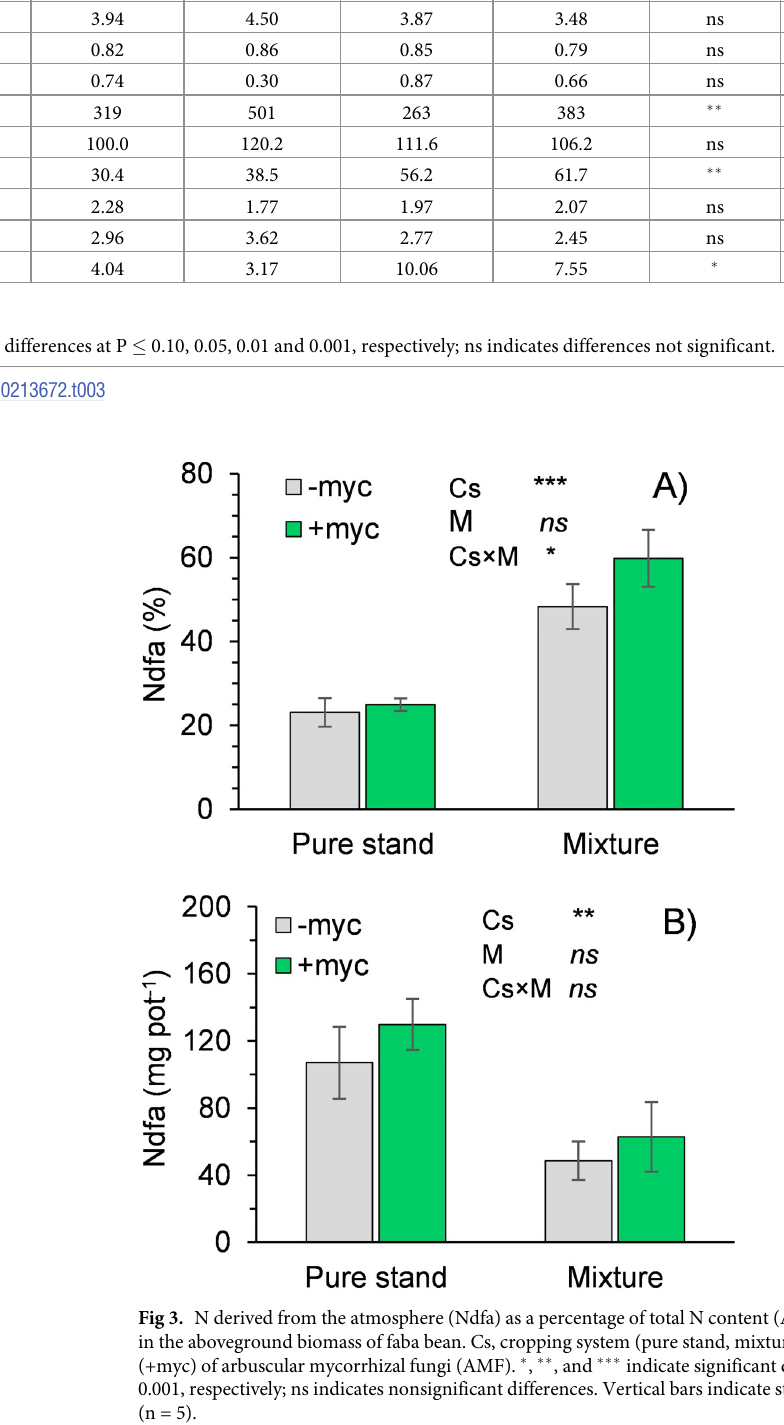
Table 3. Contents of macro- and microelements in wheat grown in pure stand or in mixture in the absence (–myc) or presence (+myc) of arbuscular mycorrhizal fungi. Cs, cropping system (pure stand, mixture); M, absence or presence of AMF. Pure stand Mixture Cs M Cs × M -myc +myc -myc +myc N g kg -1